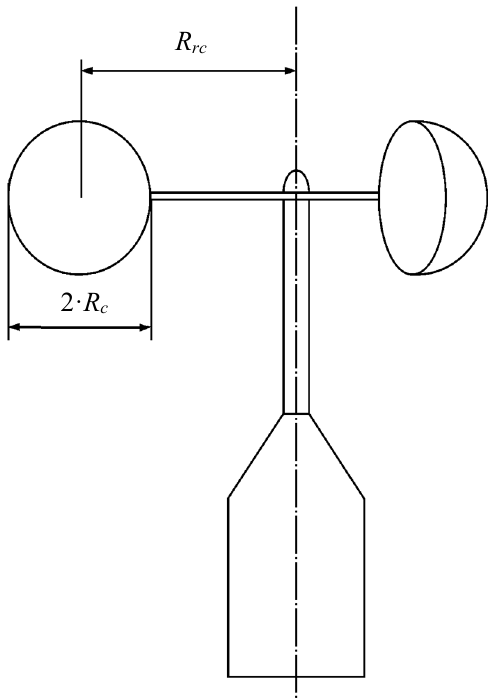
Figure 4. Sketch of a cup anemometer. The more important dimensions of the rotor, the cups’ center rotation radius, R rc , and the cups radius, R c , are indicated in the figure.